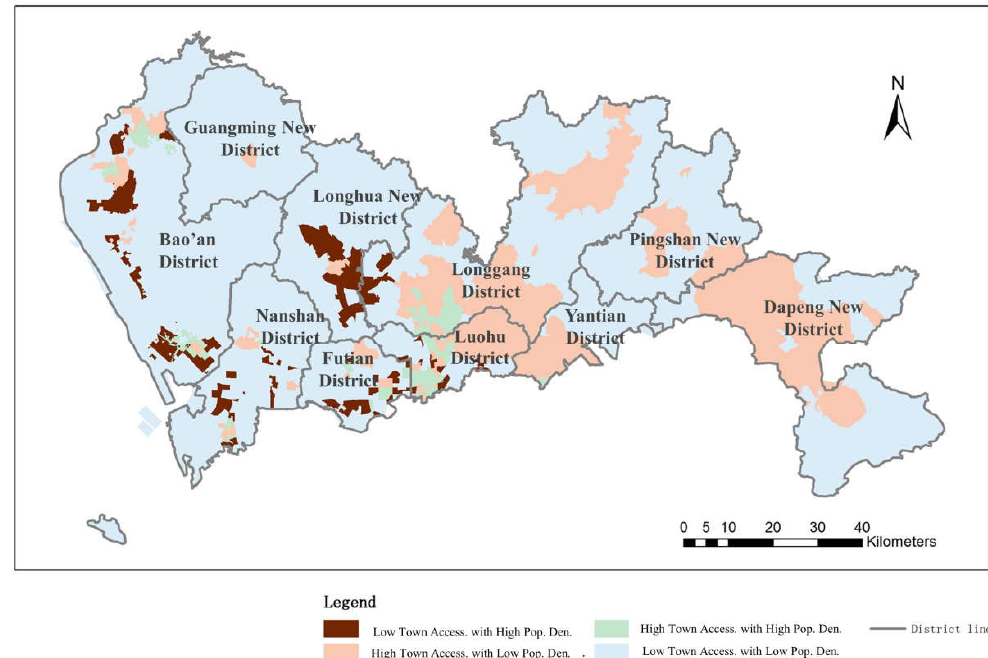
Figure 11. Balance evaluation between town‐level hospital accessibility and population density.